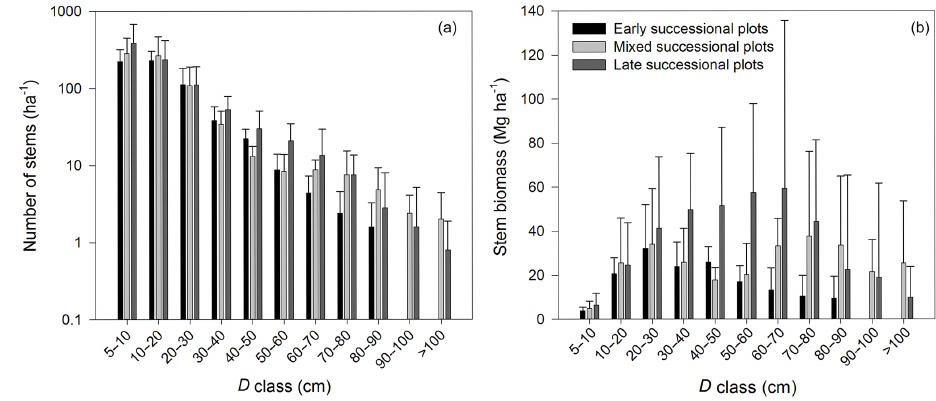
Figure 2. Distribution of the mean stem numbers (a) and stem biomass (b) per unit area in relation to D classes for three groups of plots ( n = 5 for all groups) belonging to different successional stages. The error bars are standard deviation (SD). Table 3. Wood density (basal-area-weighted average, ρ BA), above-ground biomass (AGB, stems D ≥ 5cm), relative growth rates, recruit- ment rate and mortality rate of all trees with D > 5cm, given as means ± SD and range of all plots (1–15) classified as early (ES; n = 5) or late (LS; n = 5) successional. The AGB estimates are based on species-specific or generic H vs. D relationship and ρ . Bold value, P < 0 . 05. Plot properties All plots (1–15) Plots of different successional stages Mean SD